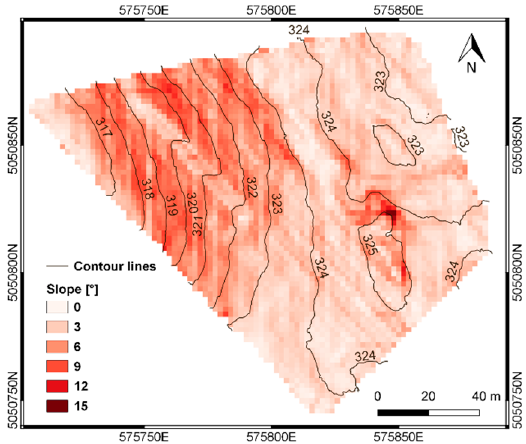
Figure 6. DSM ( a ) and DTM ( b ) produced through photogrammetric processing of multispectral (VIS- NIR) dataset.